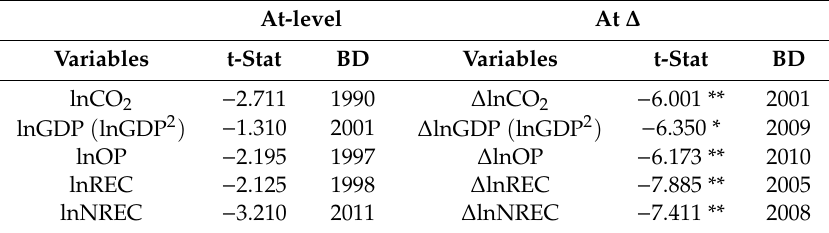
Table 1. Zivot–Andrews test results.